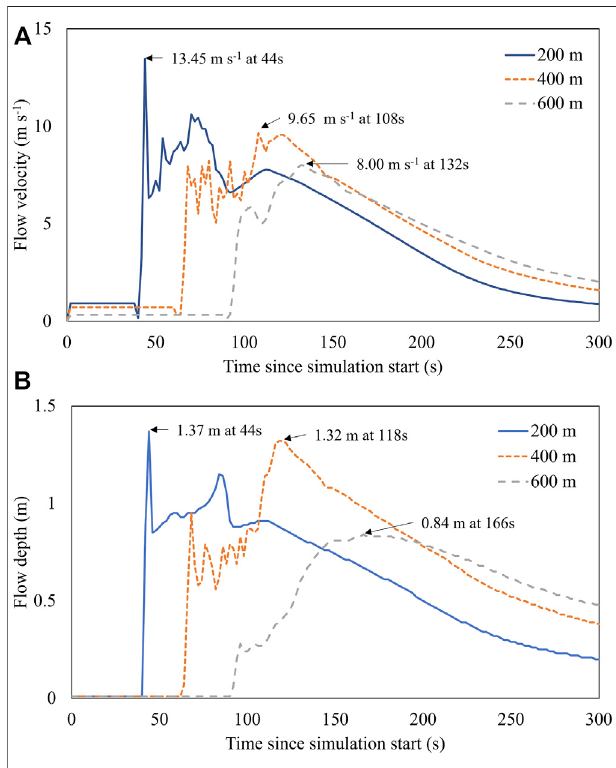
FIGURE 6 | Time-series pro fi les of fl ow velocity (A) and depth (B) at 200 m (blue solid line), 400 m (orange dotted line), and 600 m (gray dashed line) from the source